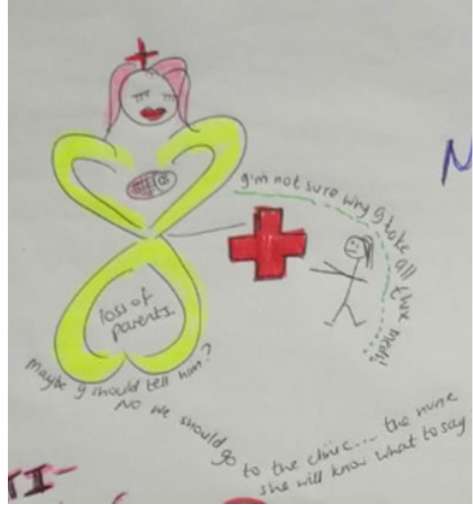
Figure 9. Grieving loss of caregivers and challenging familial